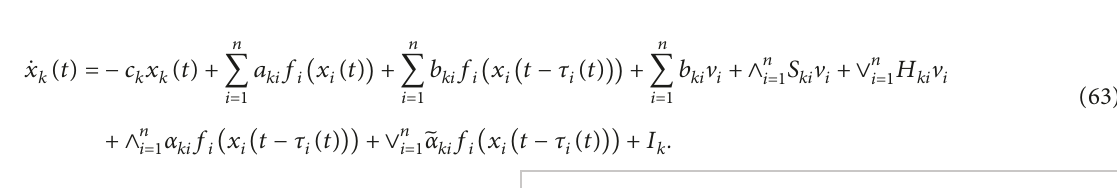
( t ) and e ( t ) for drive-response system without 1 2